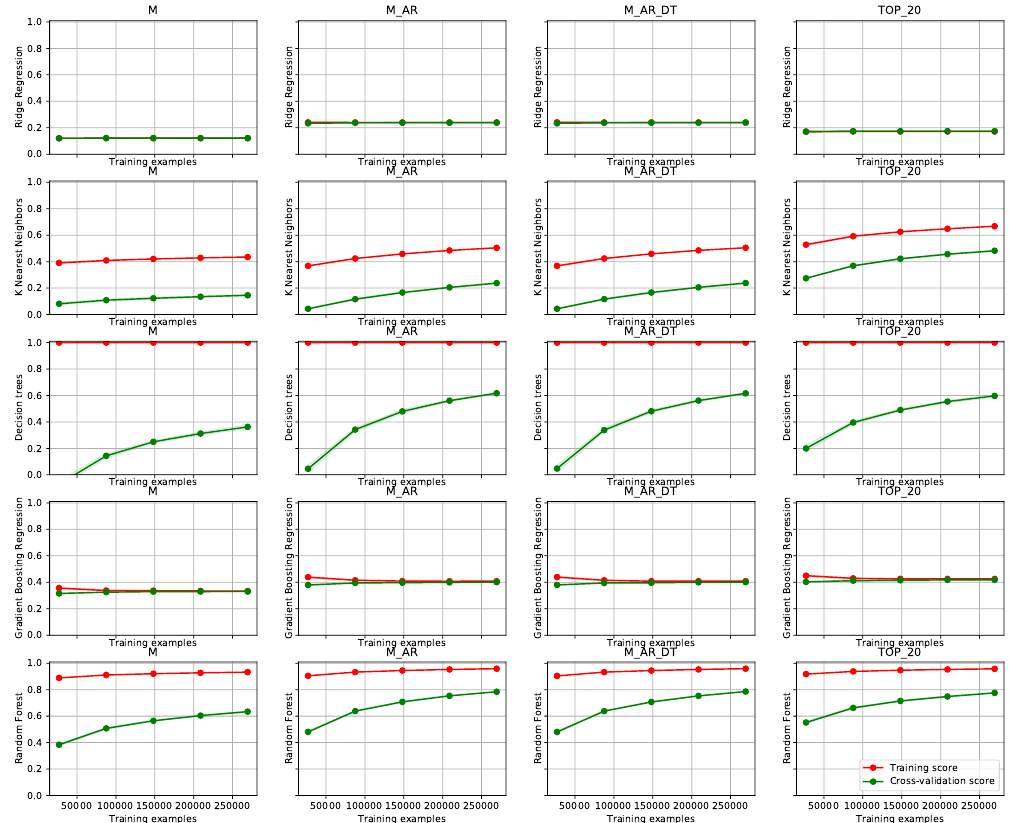
Figure 8. Learning curves on the train autonomous node use case. The structure of the figure